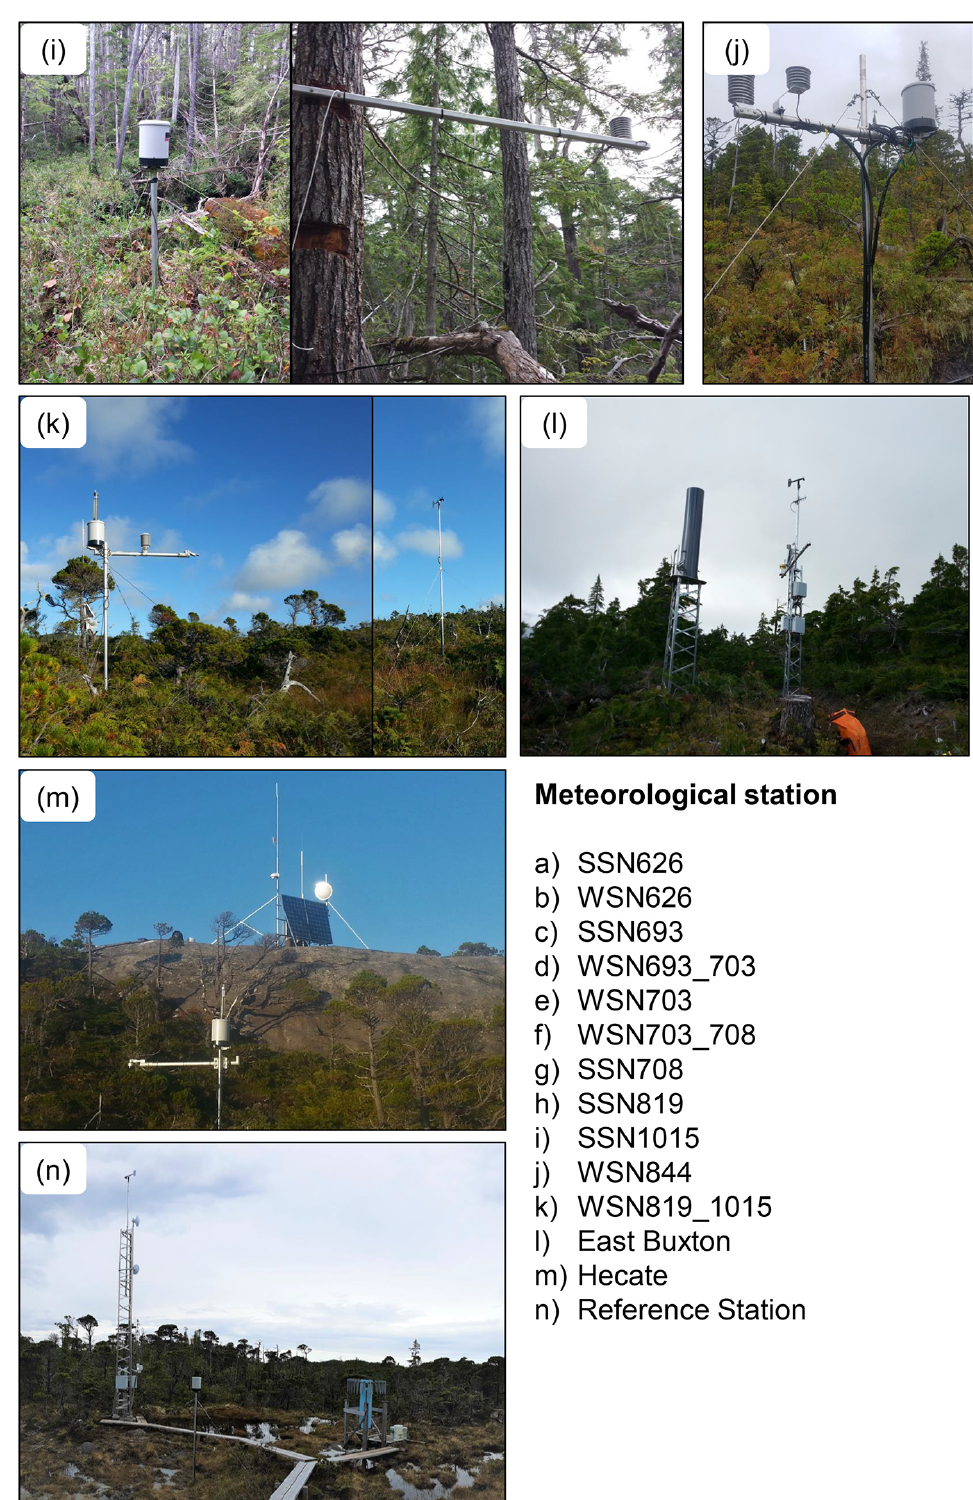
Figure A1. Images of the meteorological stations. Photos by Shawn Hateley and Bill Floyd.